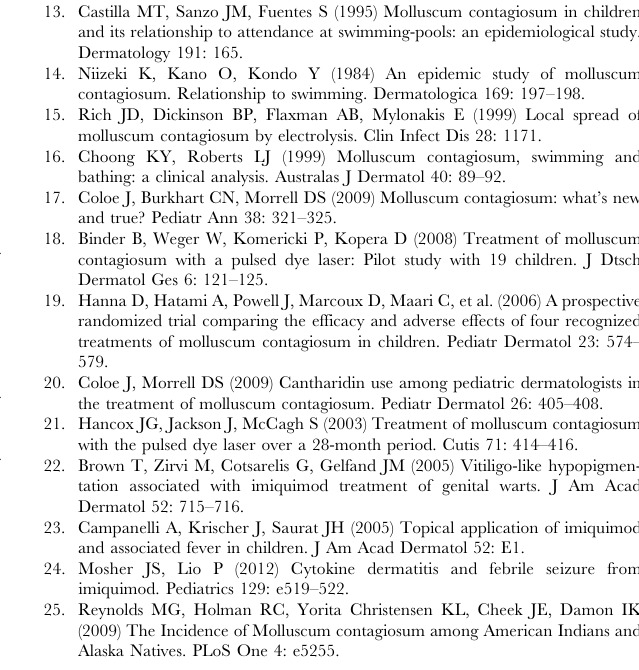
Do not touch, pick or scratch lesions Practice good hand